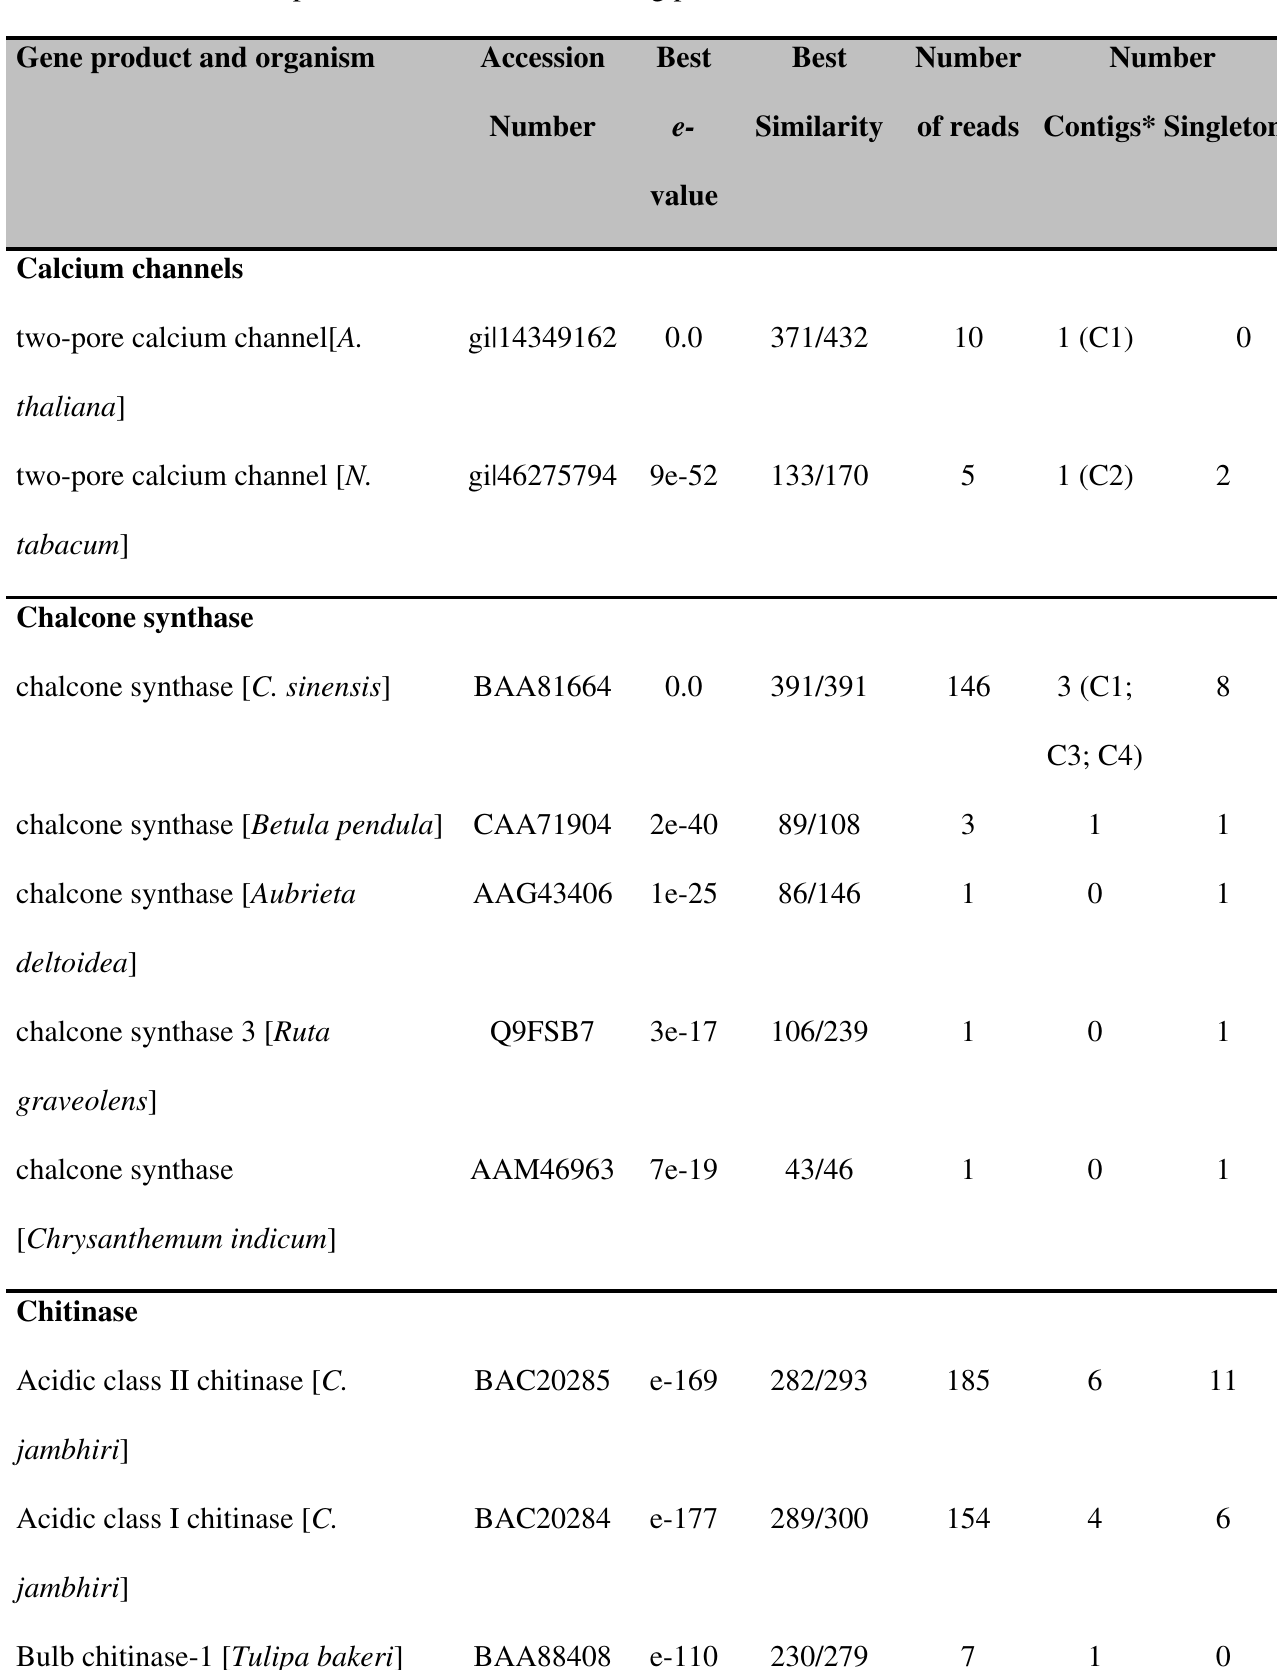
Table S1 - Description of citrus ESTs enconding proteins involved in